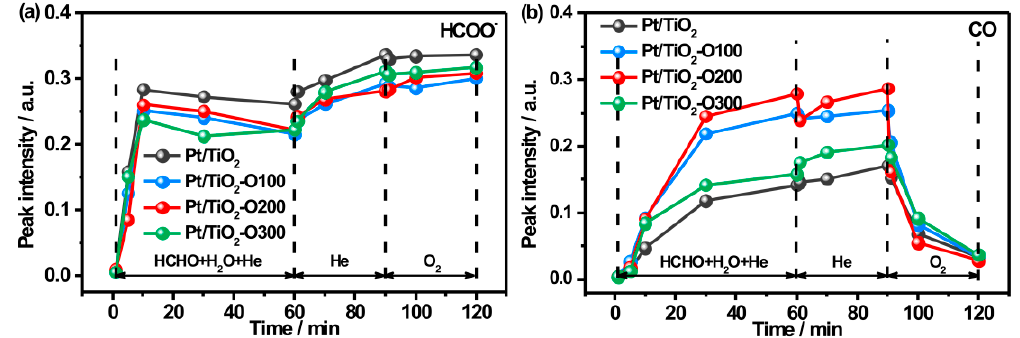
Figure 8. Signal Intensities of formate ( a ) and CO ( b ) as a function of time and atmosphere over the pristine Pt / TiO 2 catalyst and the pre-oxidized Pt / TiO 2 catalysts.